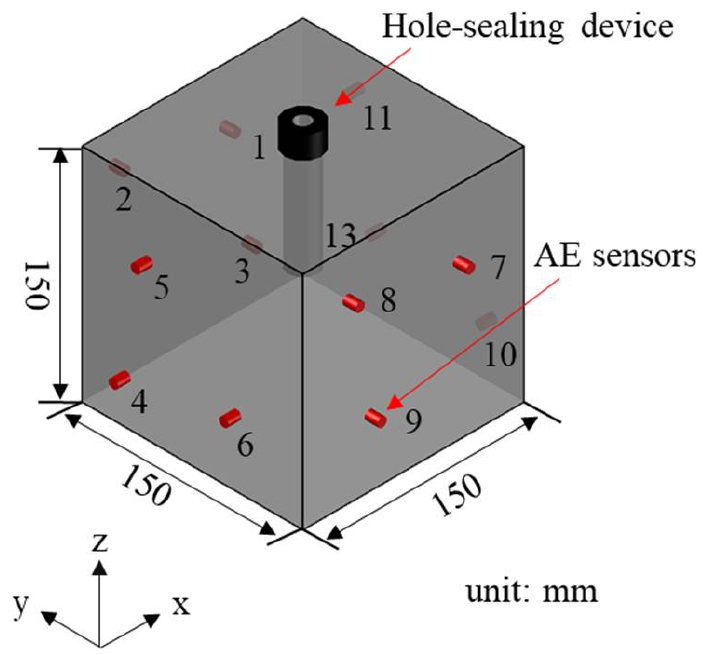
Figure 2. The layout of the AE sensors.